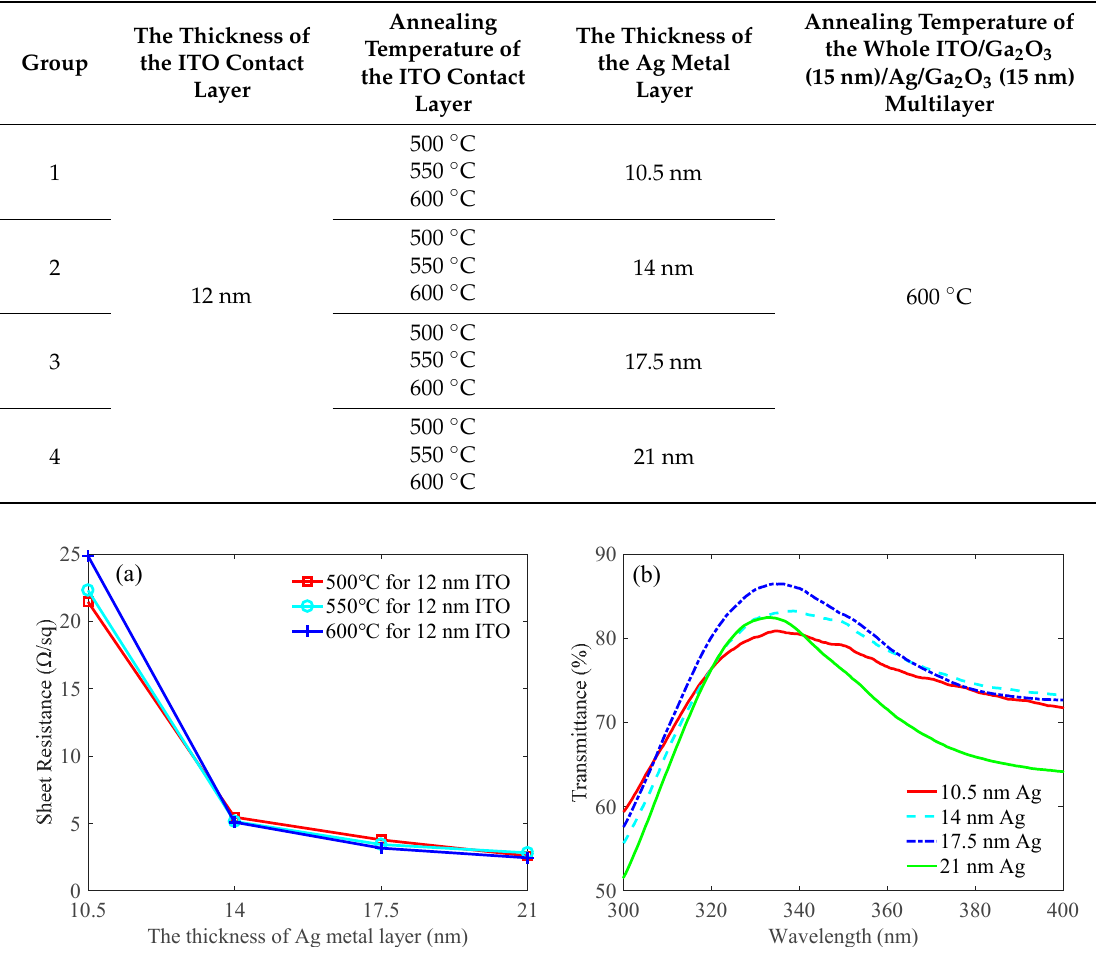
Figure 2. ( a ) Effects of the thickness of the Ag metal layer and annealing temperature of ITO contact layer on the sheet resistance of the ITO/Ga 2 O 3 /Ag/Ga 2 O 3 multilayer when the annealing temperature of the whole ITO/Ga 2 O 3 /Ag/Ga 2 O 3 multilayer was 600 ◦ C. ( b ) Effects of the thickness of the Ag metal layer on transmittance of the ITO/Ga 2 O 3 /Ag/Ga 2 O 3 multilayer when the annealing temperatures of the ITO contact layer and the whole ITO/Ga 2 O 3 /Ag/Ga 2 O 3 multilayer were 550 ◦ C and 600 ◦ C, respectively.